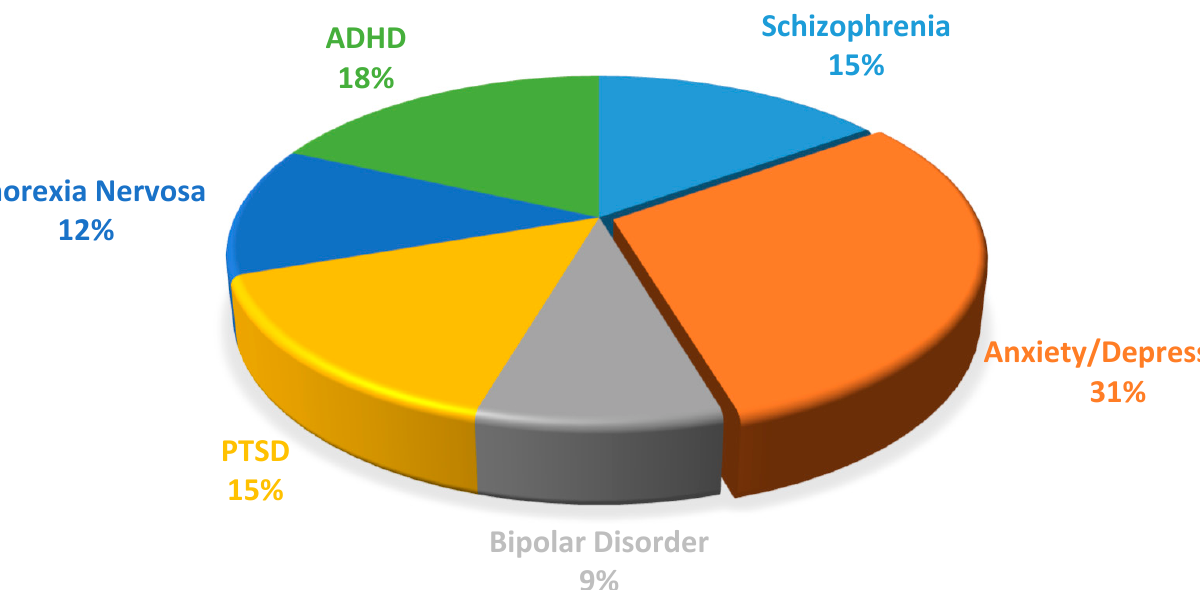
Figure 1. The proportion of reviewed articles included in this study by year with 2020 and 2021 having the most papers.